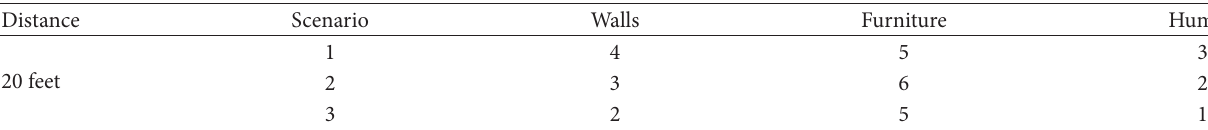
Table 3: Case 2 of experimental setup.